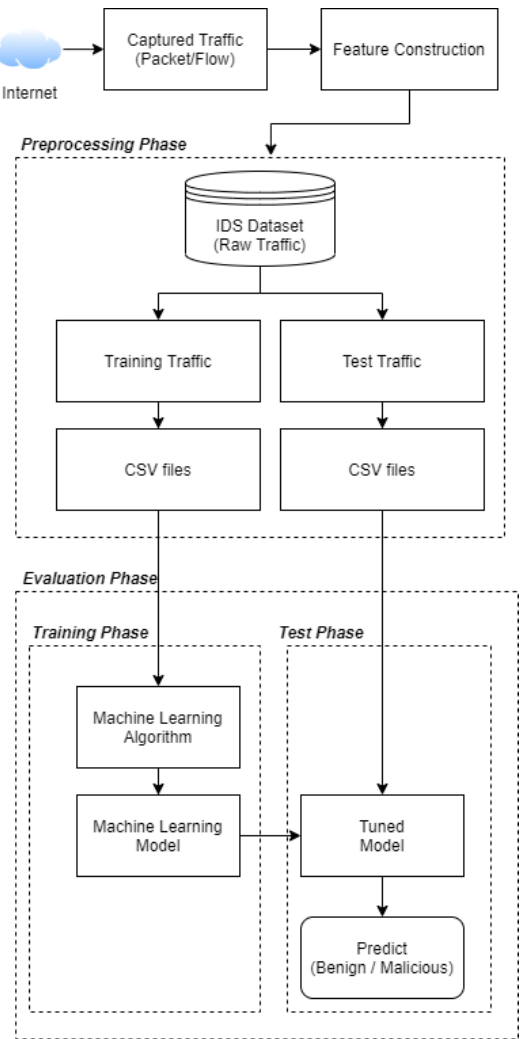
Figure 1. A general machine learning-based IDS